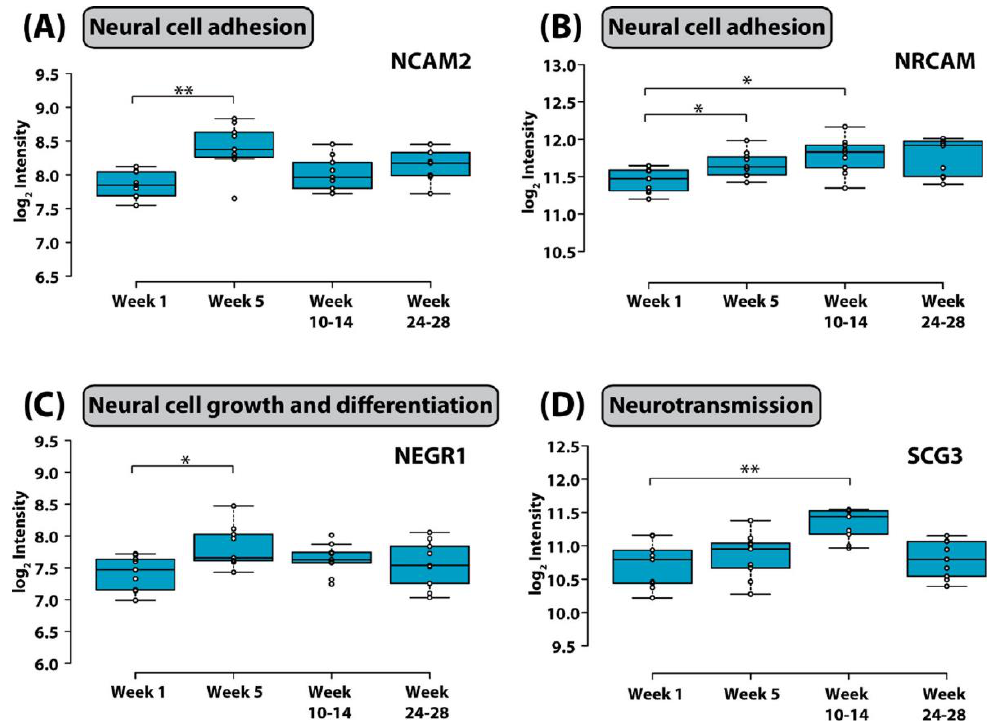
Figure 3. Box plot of the distribution of ( A ) neural cell adhesion molecule 2, ( B ) neuronal cell adhesion molecule, ( C ) neuronal growth regulator 1, and ( D ) secretogranin-3 in CSF in different stages of chemotherapy. Whiskers extend to data points that are less than 1.5* interquartile range away from the first and third quartiles, respectively. The horizontal line shows the median (*, adjusted p value < 0.1; ** adjusted p value < 0.05, Student’s t test). Figure is reprinted from Yu et al., Isobaric Labeling Strategy Utilizing 4-Plex N, N-Dimethyl Leucine (DiLeu) Tags Reveals Proteomic Changes Induced by Chemotherapy in Cerebrospinal Fluid of Children with B-Cell Acute Lymphoblastic Leukemia. J. Proteome Res. 2020,